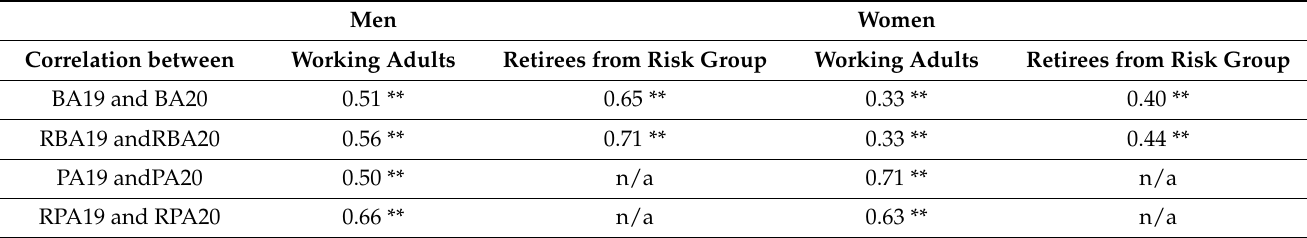
Table 2. Coefficients of correlation between indicators of biopsychological age in 2019 and 2020.